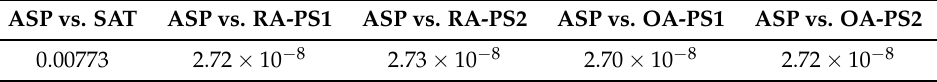
Table 3. Obtained p values from the paired samples t test. ASP vs. SAT